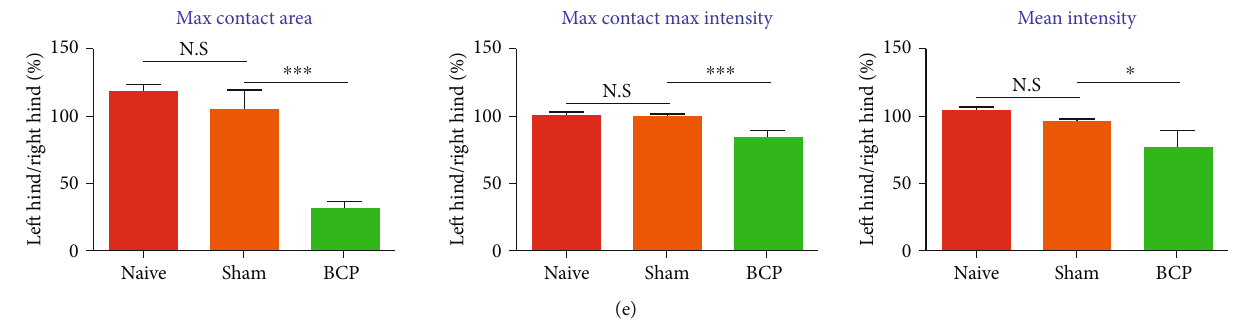
Figure 1: (a) A rat model of bone cancer pain (BCP) was successfully established. The mechanical pain threshold of the ipsilateral (left) hind foot in BCP rats showed signi fi cantly decrease from day 6 to day 18 after surgery ( ∗∗∗ p < 0 : 001 vs. the sham group; n = 6 , two-way repeated measures ANOVA (a)). (b) Hematoxylin-eosin staining showed that the normal bone trabecular structure (arrows) was destroyed in the bone marrow cavity of BCP rats accompanied by cancer cell in fi ltration after inoculation (within the dotted lines) ( n = 10 ). Scale bars: 200 μ m. n represents the number of experimental animals in each group. (c) Three-dimensional CT reconstruction showed evident cortical bone destruction in the tibial bone (arrows) 18 days after cancer cell inoculation. (d) Representative CATWALK gait results, including print view and timing view in the naïve, sham, and BCP groups. Print area is the size of the paw print. Print time represents the related contact time. (e) The percentages of left/right hind paw ratio of maximum contact area, maximum contact maximum intensity, and mean intensity decreased signi fi cantly after cancer cell inoculation. Max contact area is the print area during maximum hind paw contact; max contact max intensity is the maximum intensity during maximum hind paw contact; and mean intensity is the average of the hind paw intensity at all time points. All data were calculated as the percentage of the ipsilateral (left)/contralateral (right) hind paw ( ∗ p < 0 : 05 and ∗∗∗ p < 0 : 001 vs. the sham group; n = 6 , one-way ANOVA (e)). LH: left hind paw; RH: right hind paw; BCP: bone cancer pain. N.S: not statistically signi fi